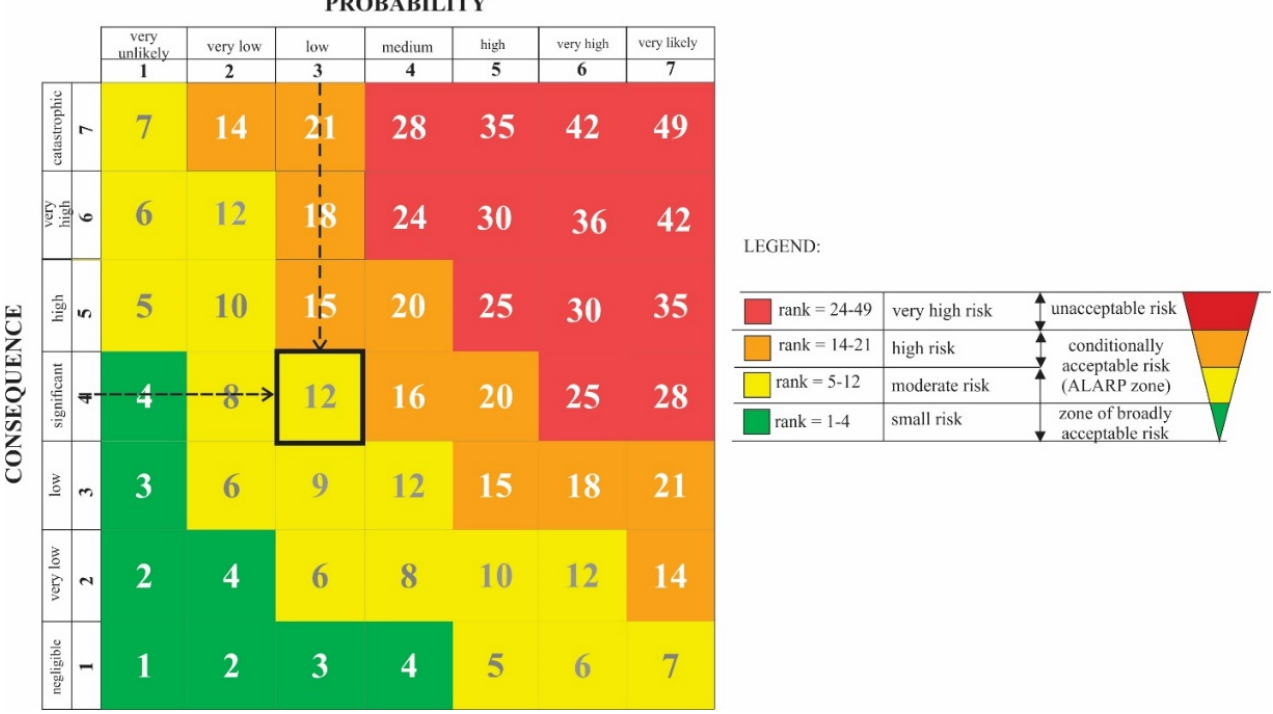
Figure 10. 7 × 7 risk matrix.